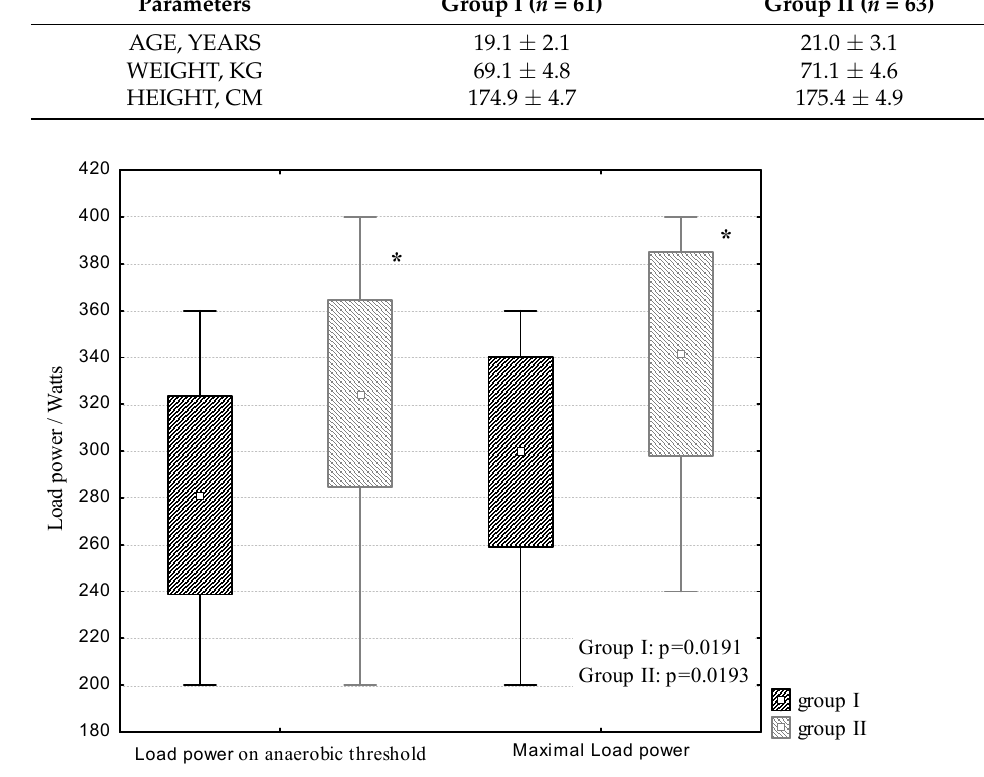
Figure 1. Load power in cross-country skiers during the exercise test on a cycle ergometer “until